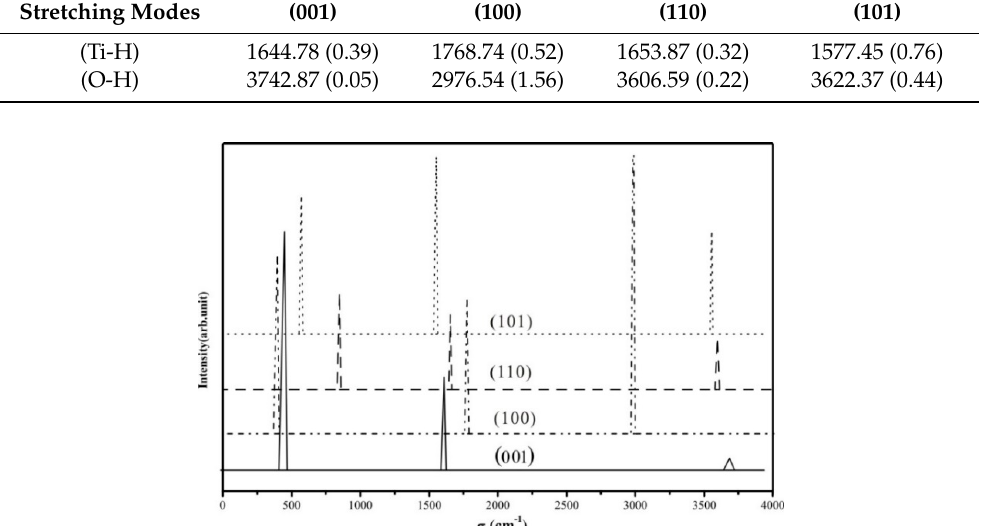
Figure 8. Computed IR spectra of the TiO 2 -(H + , H − ) species for the four selected terminations. Intensities are given in arbitrary units.